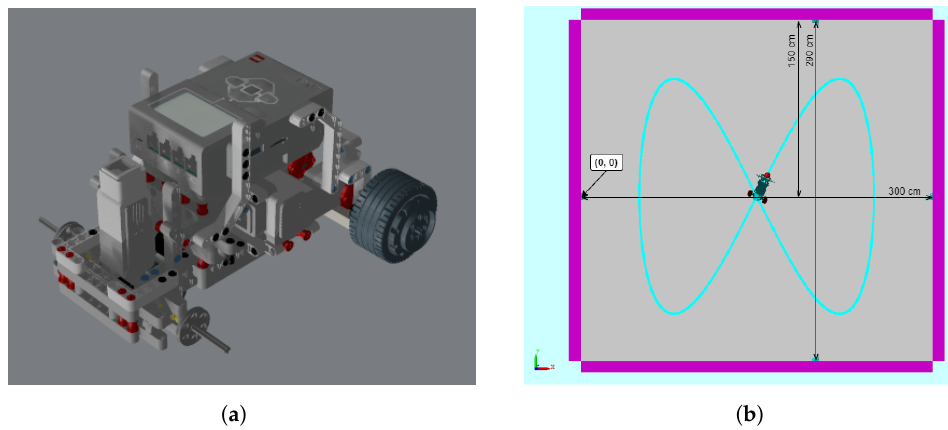
Figure 8. Model and environment. ( a ) CAD UGV model. ( b ) Simscape simulation